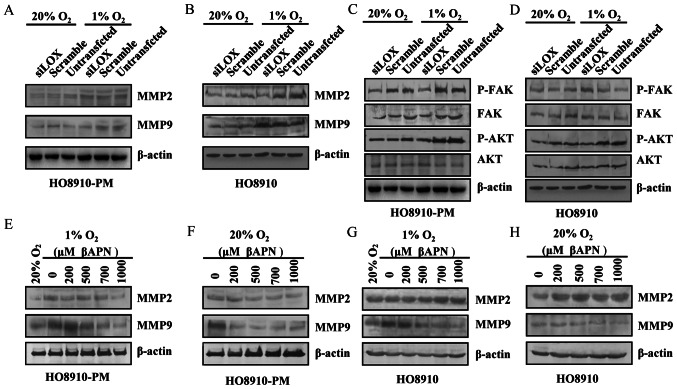
LOX catalytic activity regulates the expression of MMPs and activates the kinases FAK and Akt in ovarian cancer cells under normoxic or hypoxic conditions. HO8910-PM and HO8910 cells were transfected with LOX-siRNA or a scrambled siRNA for 24 h, and then exposed to normoxia (20% O2) or hypoxia (1% O2) for 24 h. (A and B) Western blot analysis of MMP2 and MMP9 expression. (C and D) Western blot analysis of total FAK, autophosphorylated FAK (Tyr576), total AKT and phospho-Akt (Ser473). (E and F) HO8910-PM and (G and H) HO8910 cells were cultured in 20% O2 for 24 h alone or under reoxygenation conditions (24 h at 1% O2 followed by 6 h 20% O2) in the absence or presence of increasing doses of βAPN, and then subjected to western blot analysis for MMP2 and MMP9.